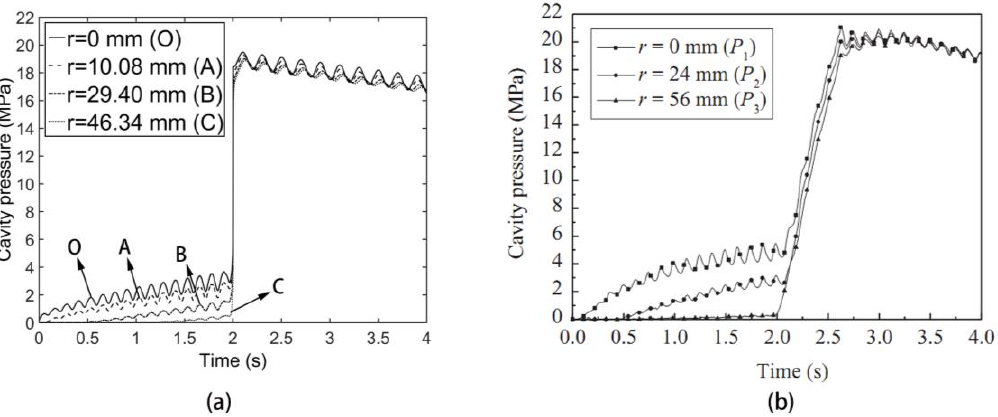
Figure 4. Pressure response for the dynamic injection molding technology (DIMT) case. ( a ) Simulation result; and ( b ) experimental monitoring result [7].